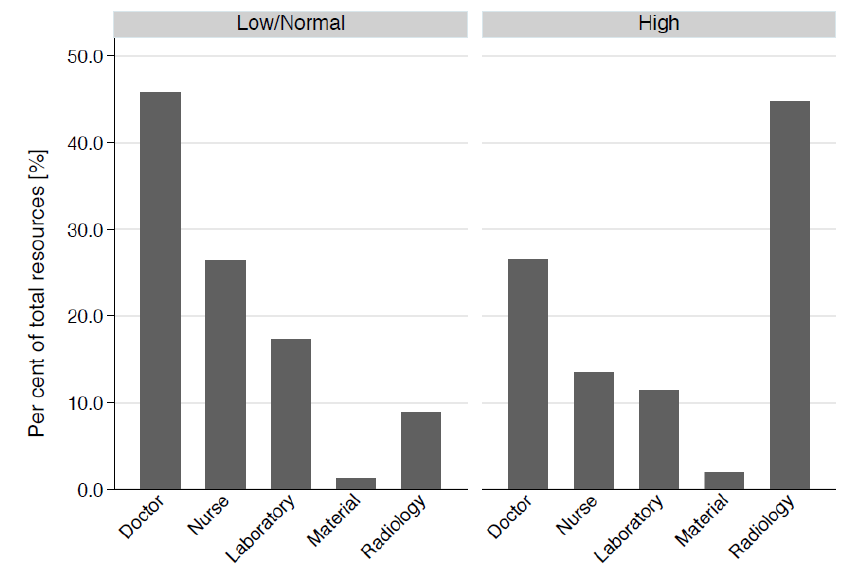
Figure 3. Comparison of the distribution of the total work according to the different resource categories according to type of resource consumption.